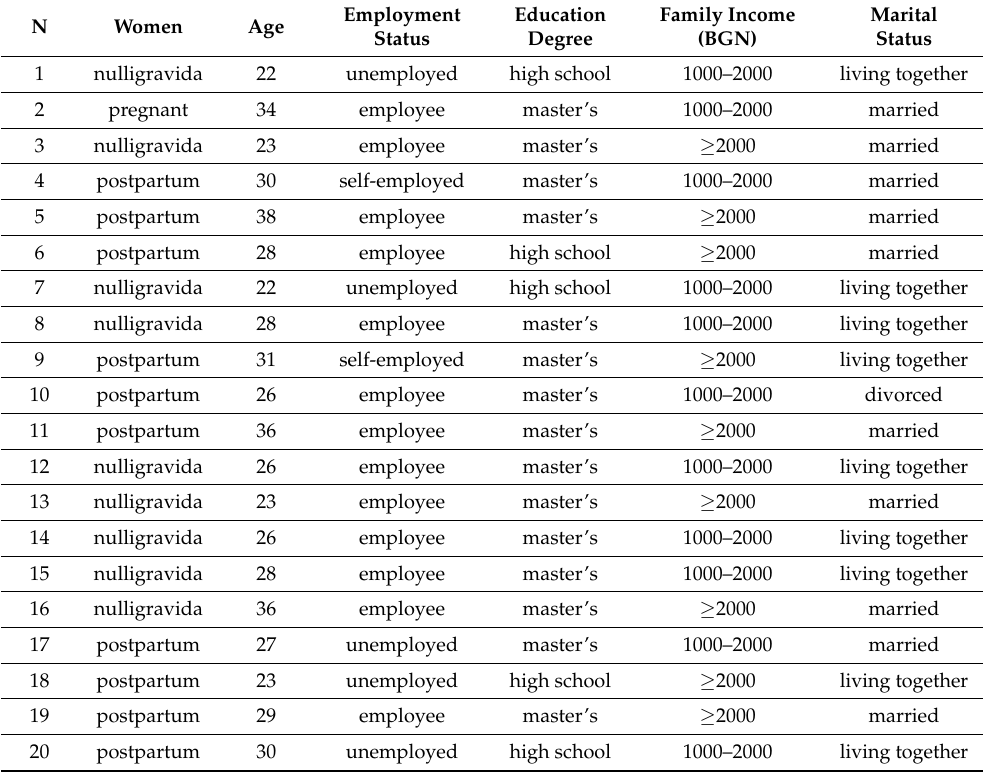
Table 3. Participants’